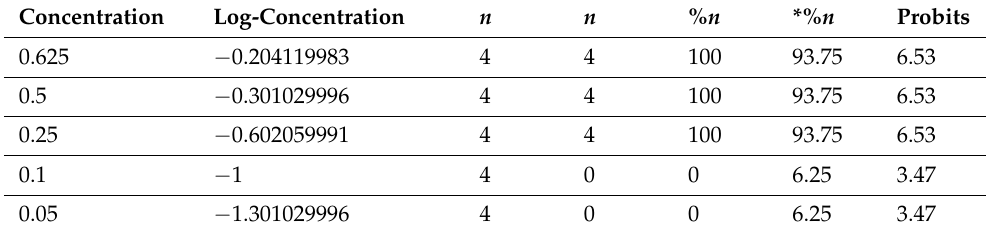
Table 2. Probits for LD 50 analysis of the venom.